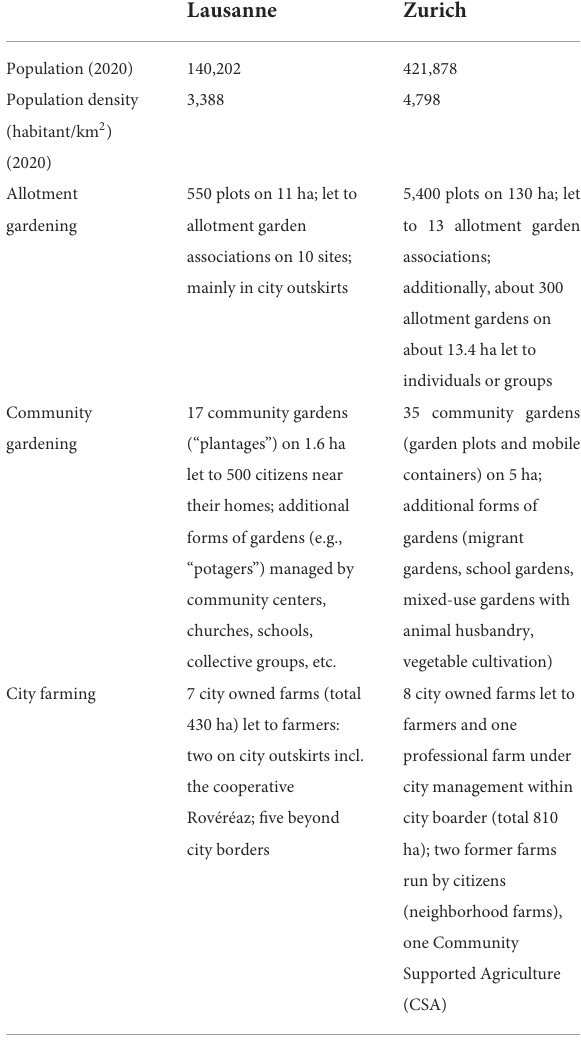
TABLE 1 Characteristics on gardening and farming in Lausanne and